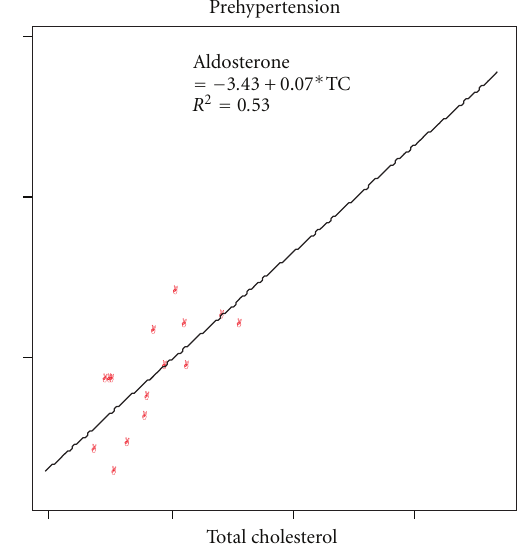
Figure 3: Correlation between total cholesterol and aldosterone.